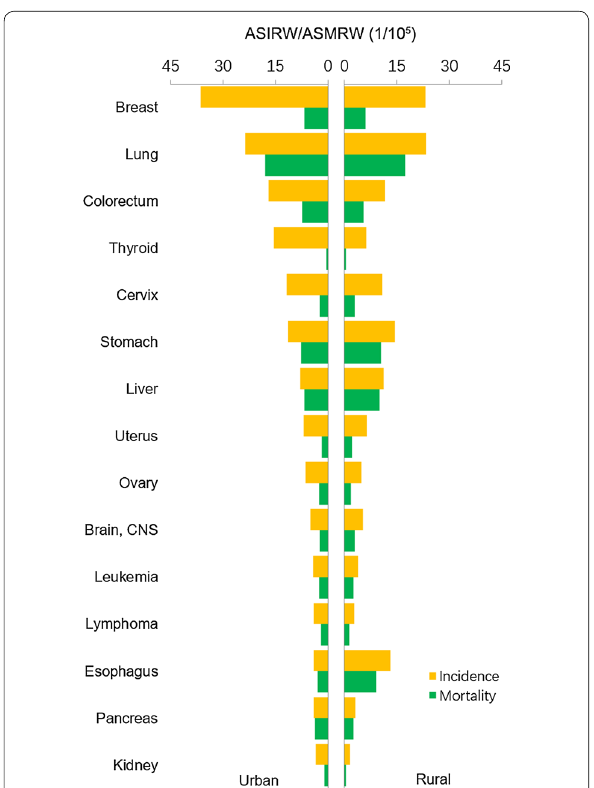
Fig. 4 ASIRW and ASMRW in urban areas and rural areas for